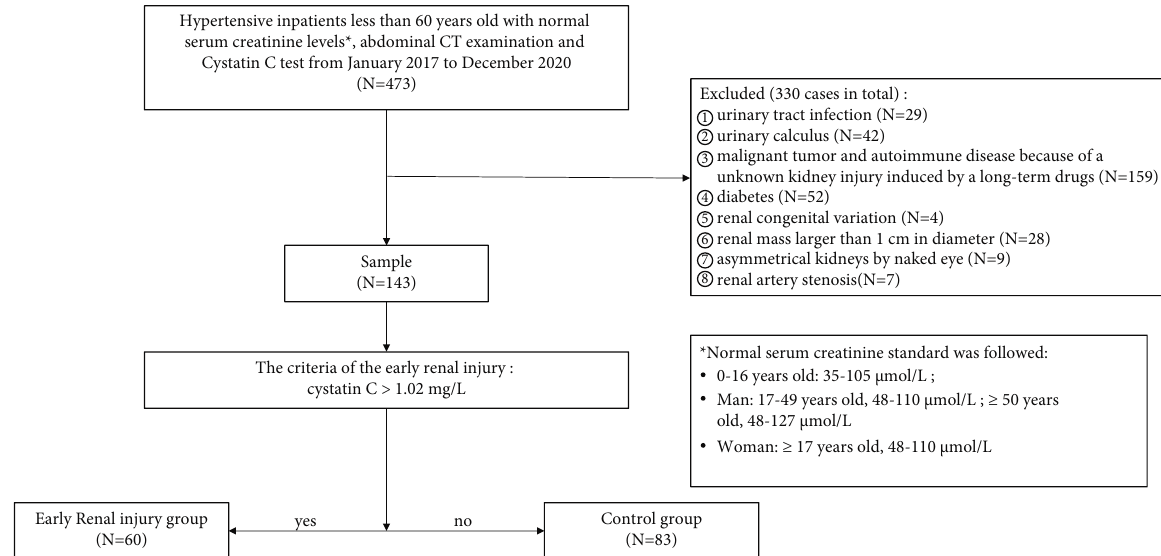
Figure 1: Flow chart of the selection of patients with arterial